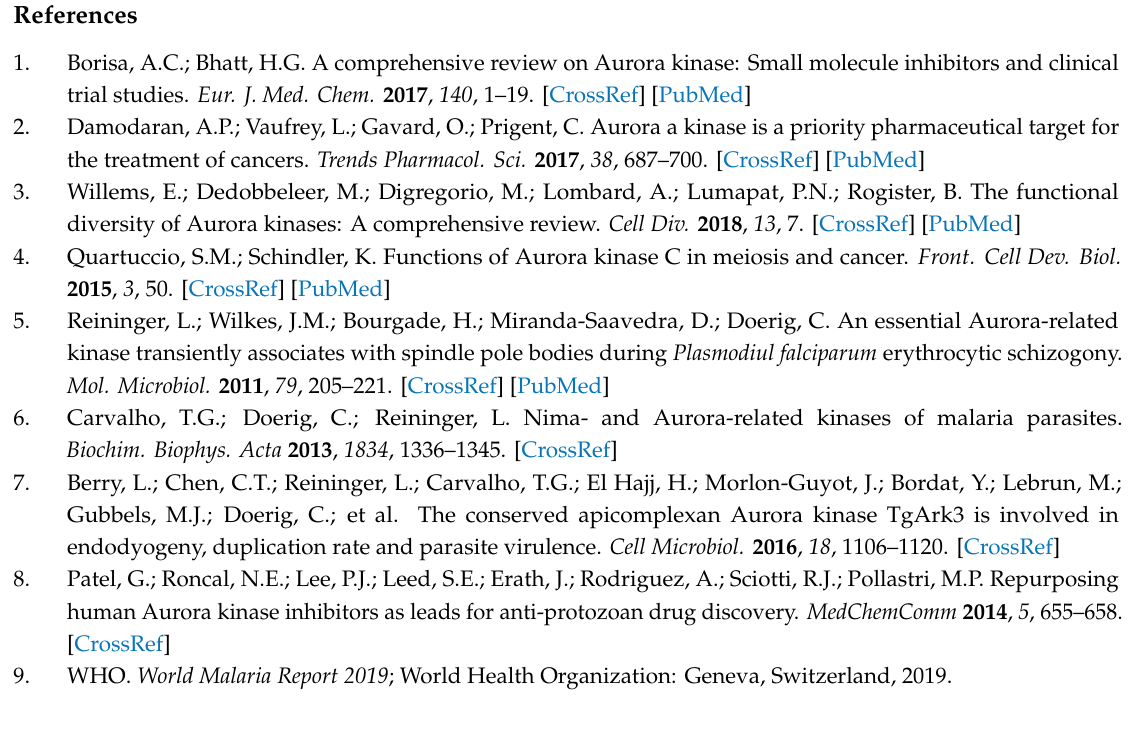
Supplementary Materials: 1 H-NMR data (Table S1) and 13 C-NMR data (Table S2) of isolated compounds from S. dialsiana Y.C. Wu are available